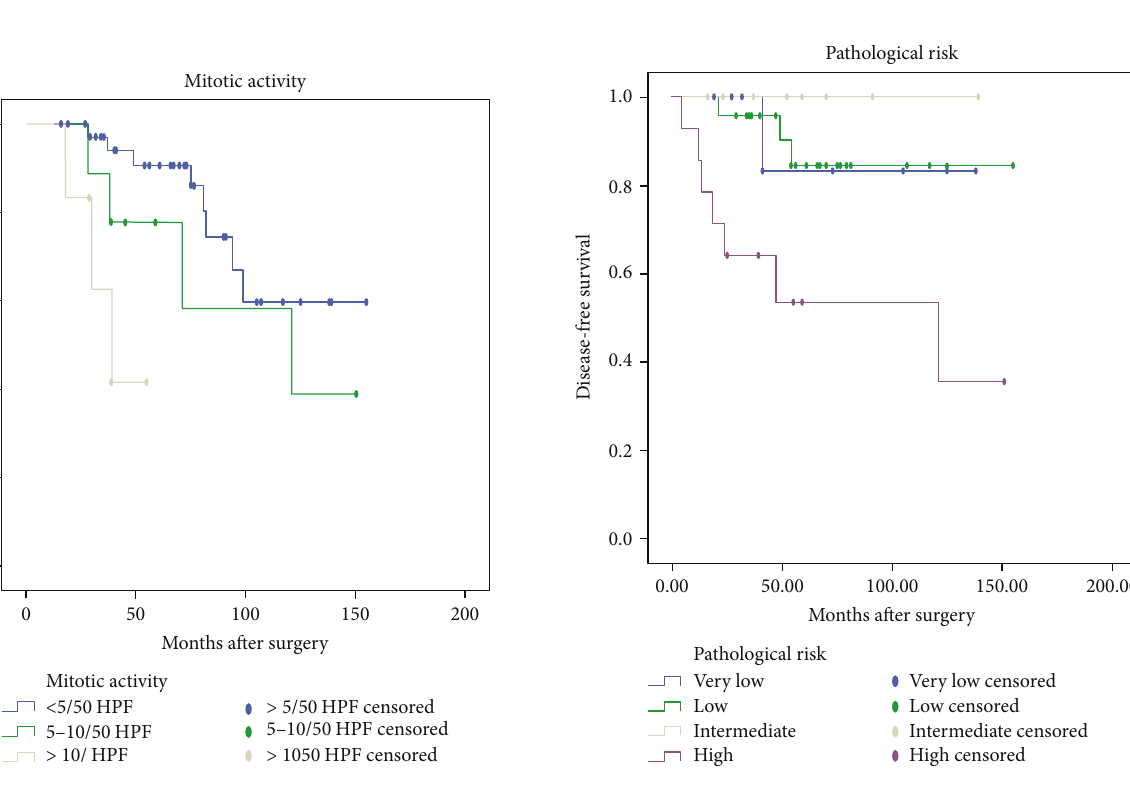
Figure 2: The Kaplan-Meier survival analysis of di ff erent levels of mitotic activity indicates the di ff erent prognoses of duodenal stromal tumor. Higher mitotic activity predicts a poorer prognosis.